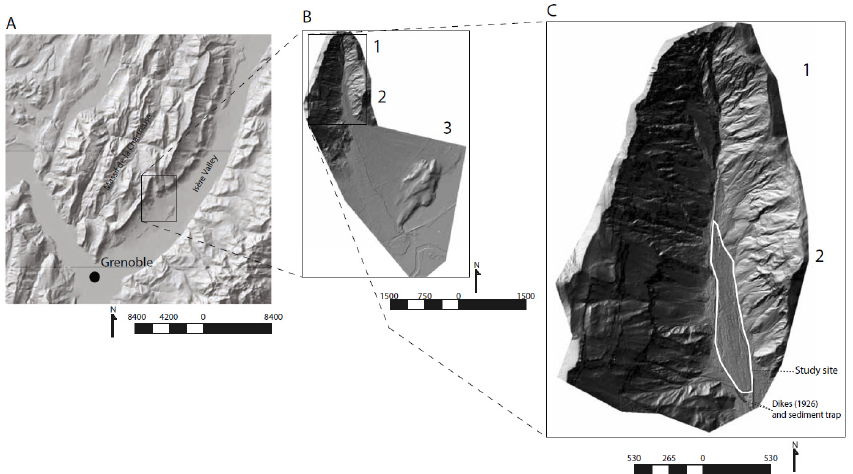
Fig. 2. (A) The Manival torrent is located on the southeastern slopes of the Massif de la Chartreuse, 10km northeast of Grenoble. (B) It is composed of three characteristic parts: (1) the upper basin, (2) a large valley with an active flow channel and several abandoned channels, and (3) the debris-flow cone. (C) Detail of the study